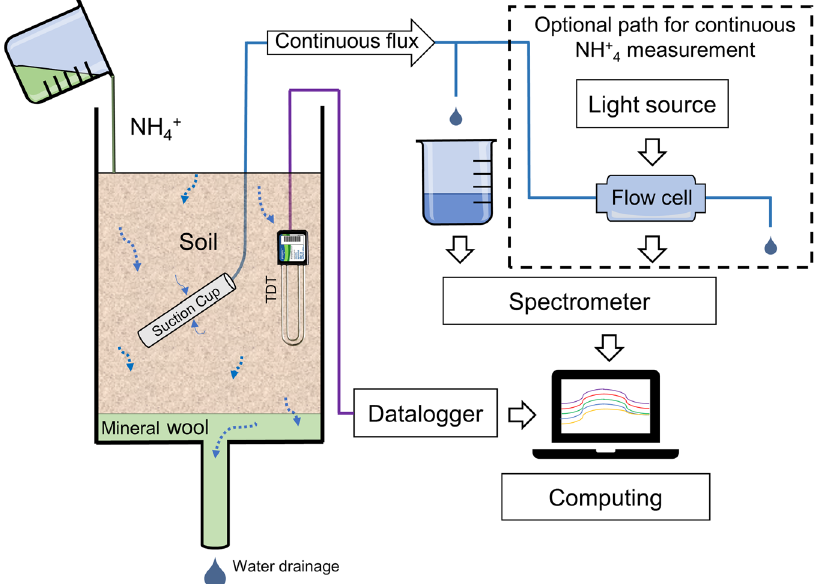
Fig. 5 Column setup. Illustration of the experimental column setup for measurement of ammonium transport in soil. The ‘ optional path ’ shows how to apply the approach with a real-time fi eld sensor for measuring ammonium in the soil pore